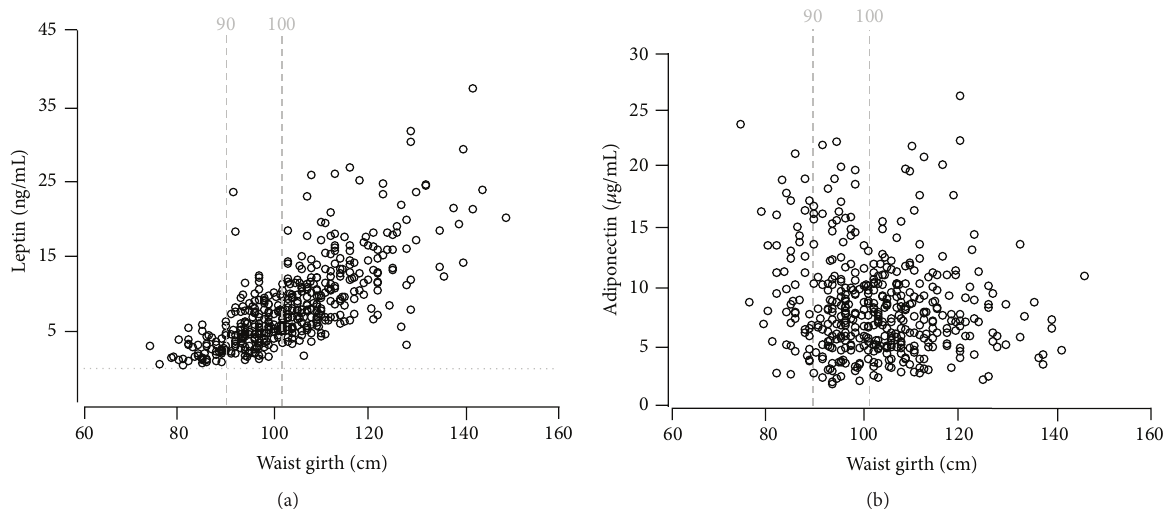
Figure 1: Scattered plots of leptin (a) and adiponectin (b) as a function of waist girth. There was a trend for a linear association of leptin to waist girth ( 𝑅 2 = .56 ; 𝑃 < .001 ). Subjects with waist girths below 90cm consistently had the lowest leptin levels. More interindividual variations were noted in the leptin levels of subjects in waist girth in the range of 90 to 101cm. In contrast to leptin, adiponectin was not linearly associated with waist girth (b). There was a striking interindividual variation in adiponectin levels at each waist girth subcategory, that is, nonobese, overweight, and